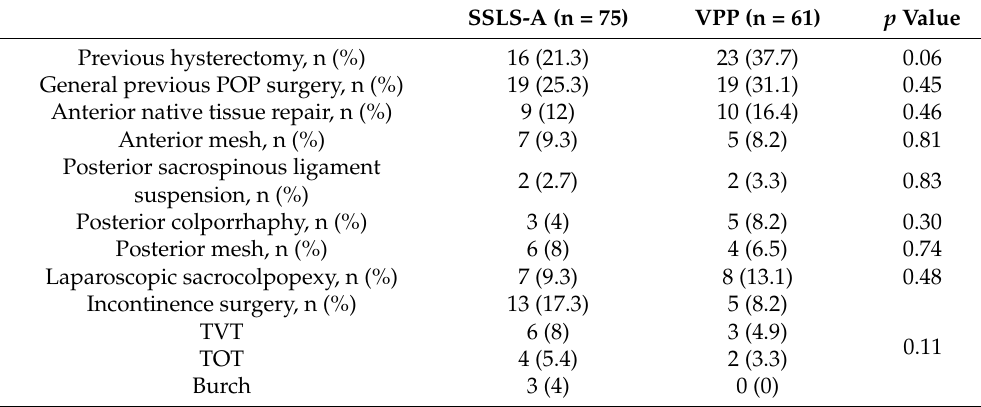
Table 2. Previous gynecological and pelvic surgeries of the study population.